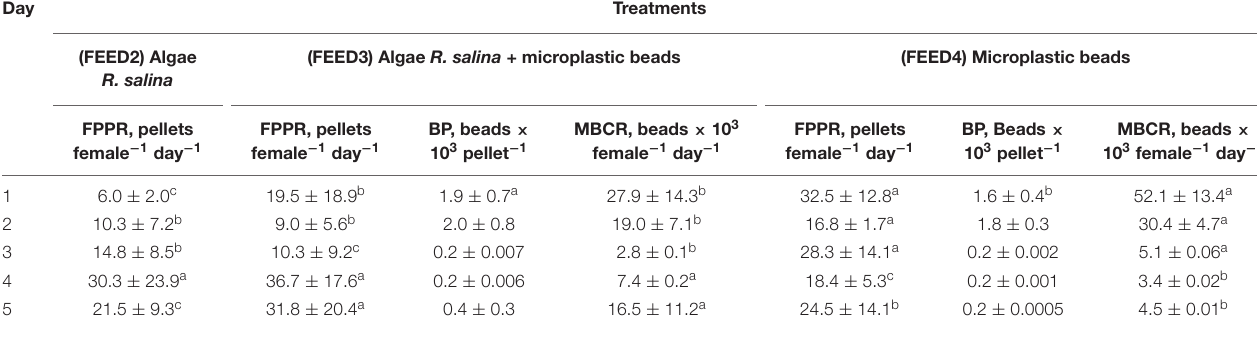
∼ 5,000 beads ml − 1 ) and Rhodomonas salina algae ∼ 5,000 cells ml − 1 (Treatment FEED5).